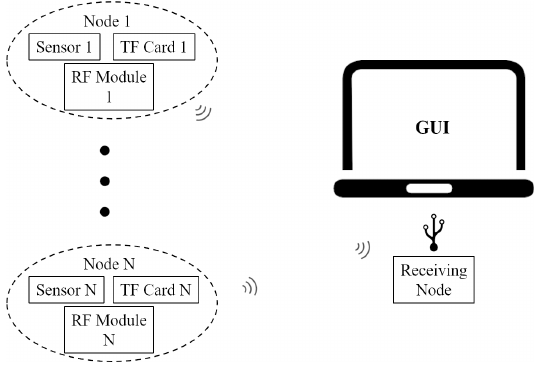
Figure 2. The block diagram of the experimental